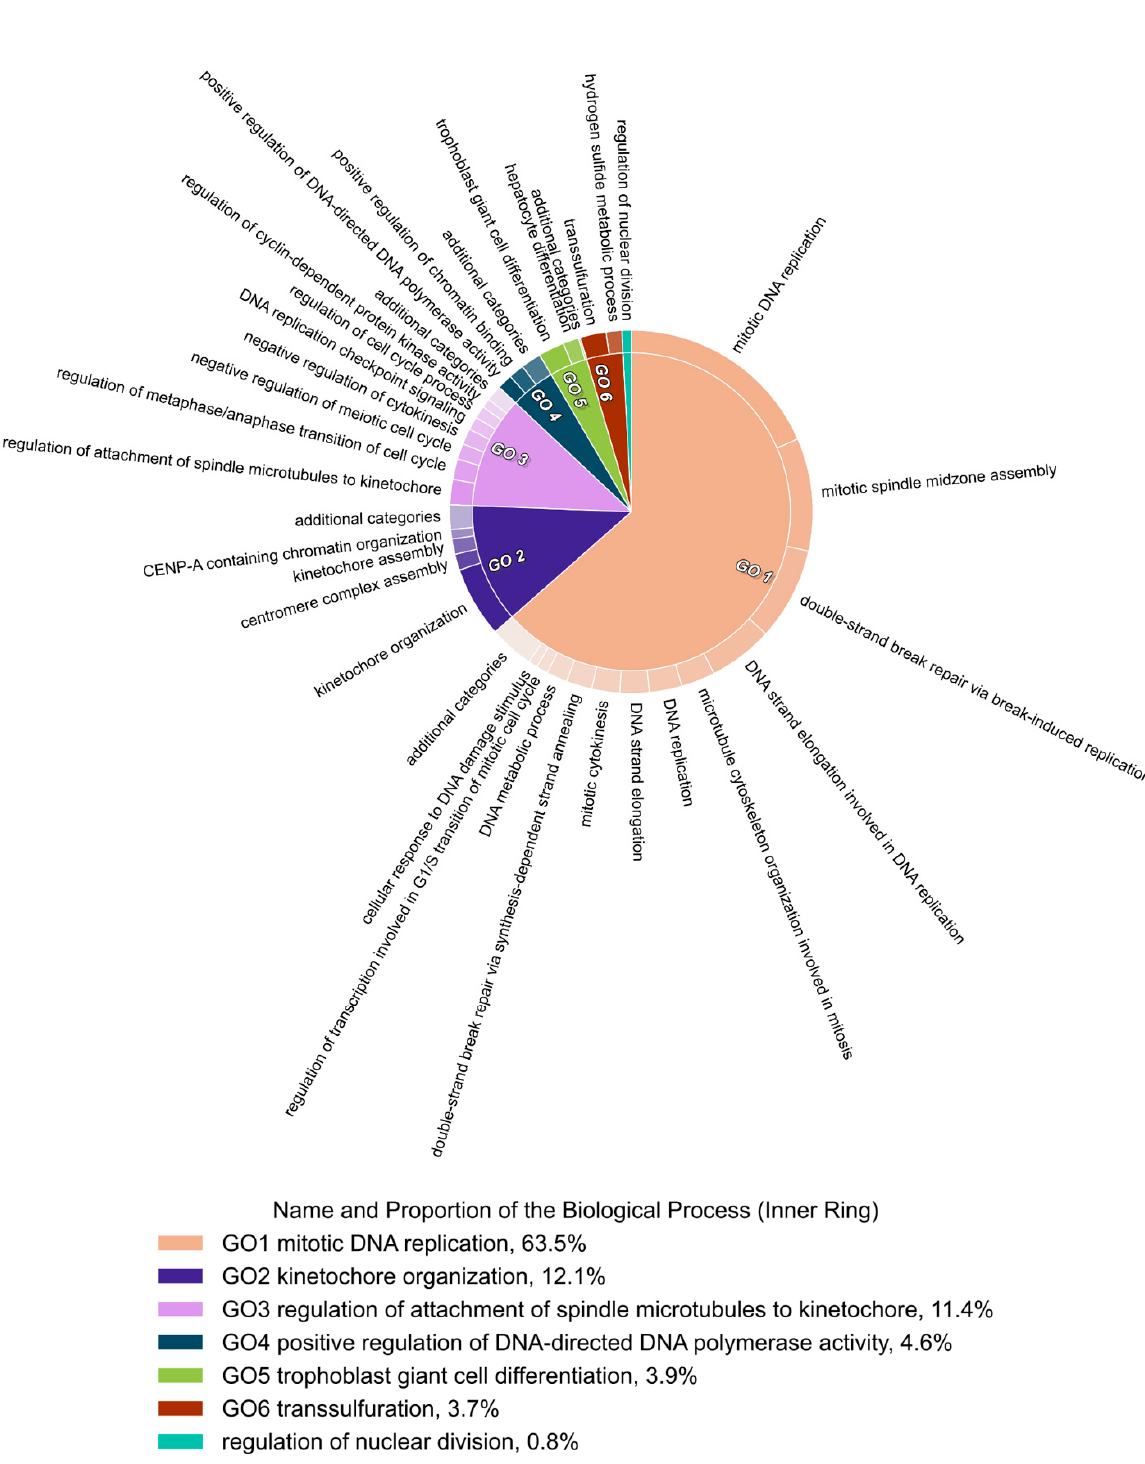
Figure 8. Identified gene ontology clusters after Ento+AZD combined exposure. Gene ontology terms were clustered by CirGO tool. Legend indicates the representative GO terms (GO clusters).